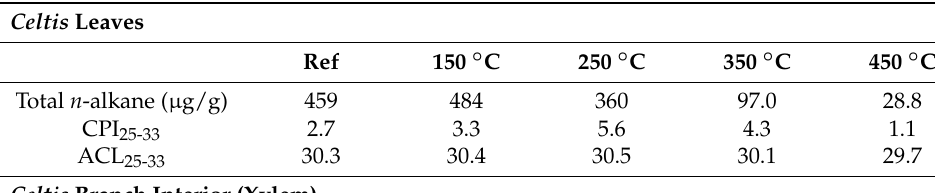
Table 1. Quantitative results for total n -alkane concentration, Carbon Preference Index (CPI), and Average Chain Length (ACL). Ref indicates unheated reference samples.